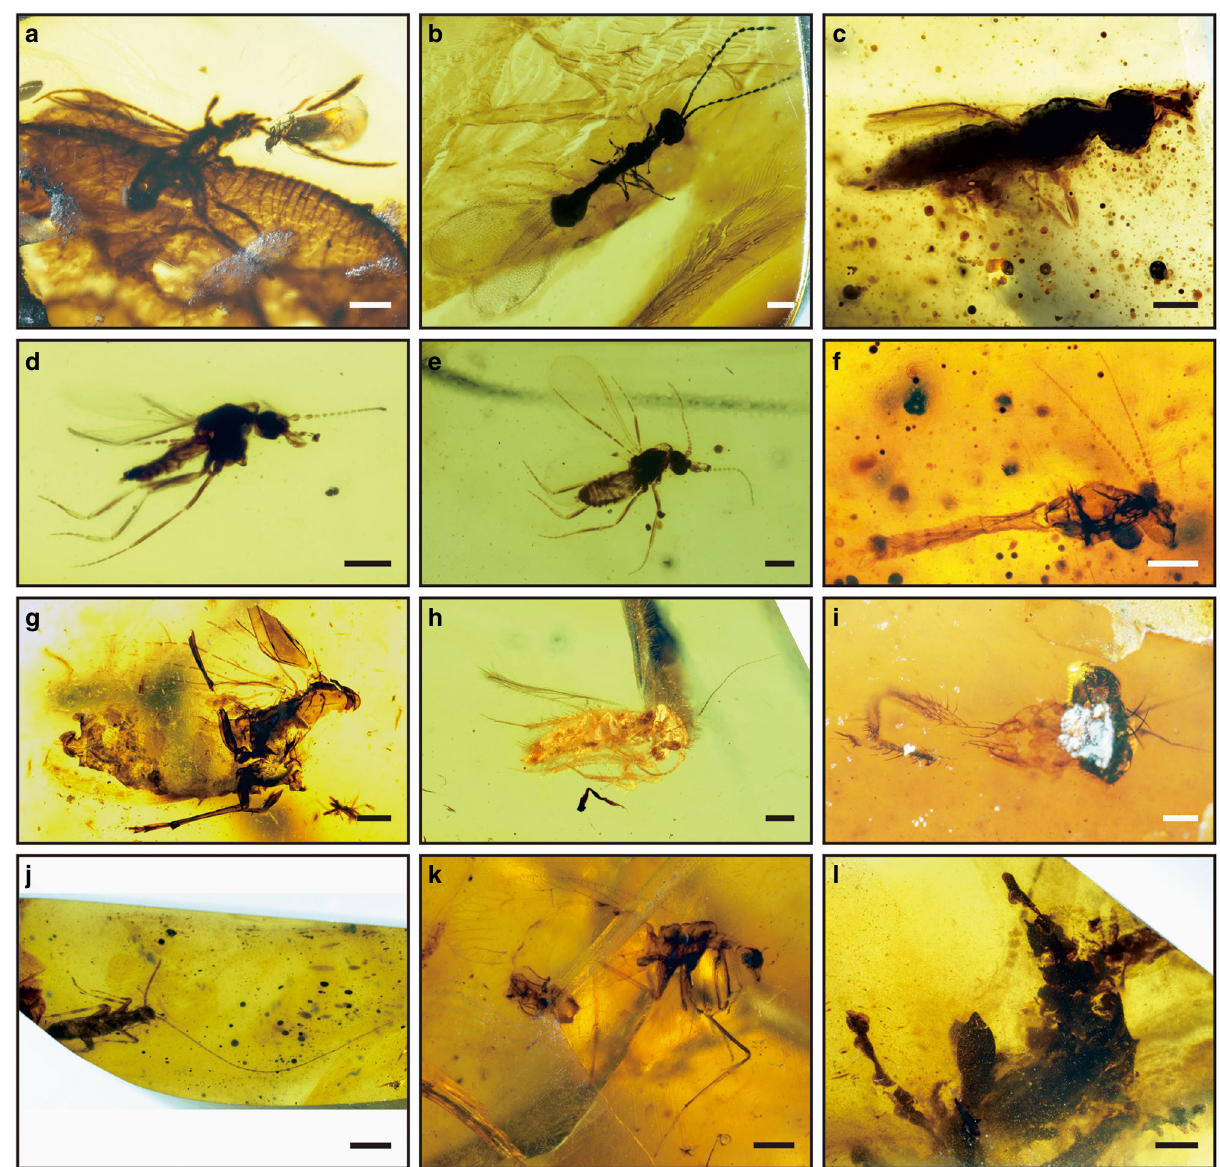
Fig. 2 Photographs of typical inclusions in Tilin amber. a – c Parasitic wasp (Hymenoptera). a Braconidae, NIGP168500. b Diapriidae, NIGP168501. c Scelionidae, NIGP168502. d , e Biting midges (Diptera: Ceratopogonidae: Protoculicoides ), NIGP168503. f Non-biting midge (Diptera: Chironomidae), NIGP168504. g Planthopper (Hemiptera: Achilidae), NIGP168505. h Scaly-winged barklice (Psocoptera: Lepidopsocidae), NIGP168506. i Cockroach (Blattaria), NIGP168507. j Mantis (Mantodea: Burmantis ), NIGP168508. k Beaded lacewing (Neuroptera: Berothidae), NIGP168505. l Moss (Bryophyta), NIGP168509. Scale bars, 0.5 mm ( a , g , k ), 0.2 mm ( b – f , h , i ), 1 mm ( j ), and 2 mm ( l